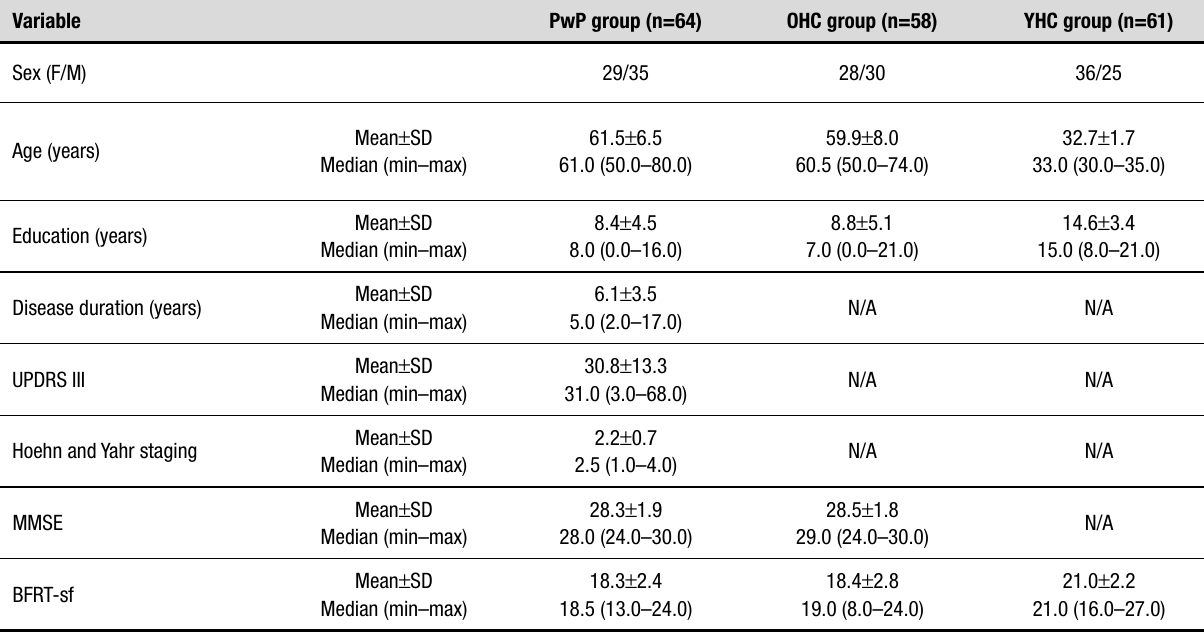
Table 2. Clinical characteristics of the